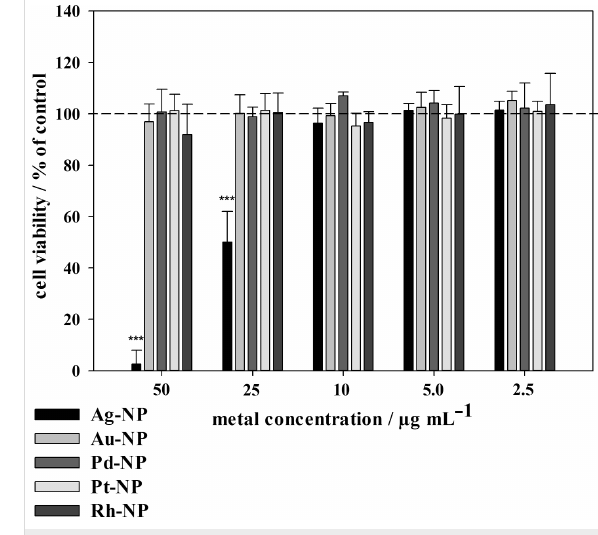
Figure 7: Influence of noble metal nanoparticles on the viability of human mesenchymal stem cells. The cells were treated with 2.5 to 50 µg mL − 1 for 24 h under cell culture conditions. Viable cells were quantified by digital image processing (phase analysis). The data are expressed as mean ± SD ( n = 5 independent experiments) given as the percentage of the control (cells cultured without nanoparticles). Asterisks (*) indicate significant differences in comparison to the control (*** p ≤ 0.001).